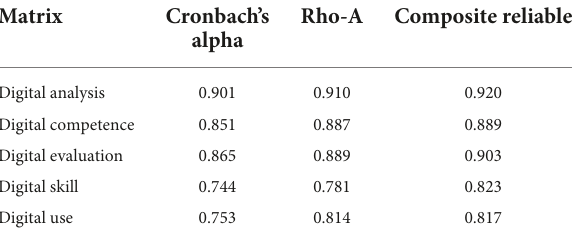
TABLE 2 Reliability and validity test results.